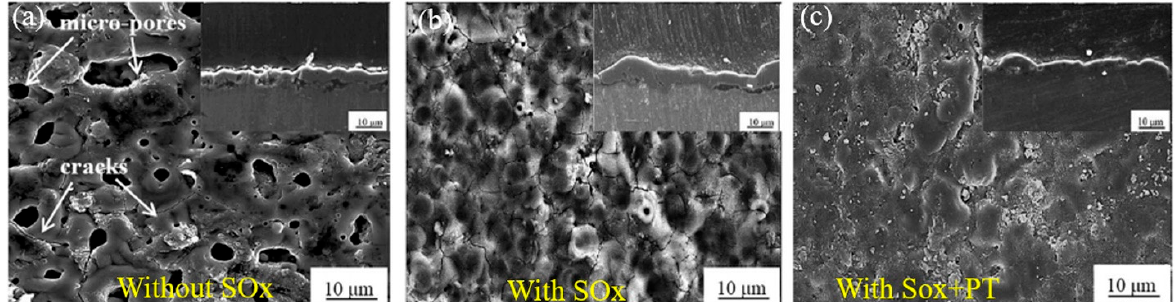
Figure 6. ( a , b ) SEM images of the PEO coatings produced in an electrolyte without SO x and with SO x , respectively. ( c ) SEM image of the PEO coating produced in the electrolyte with SO x followed by post-treatment in a SO x solution. The insets show the corresponding cross-sectional images. Reprinted from permission from [42]. Copyright 2015 Royal Society of Chemistry.